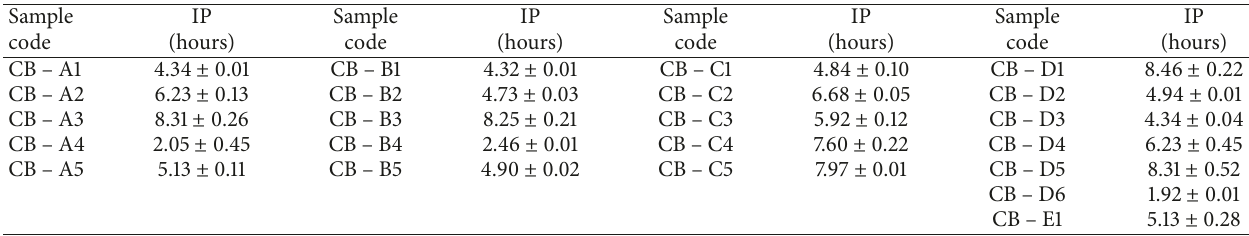
Table 5: Induction period (IP) for soybean biodiesel samples, containing binary additive blends, obtained by Rancimat method.